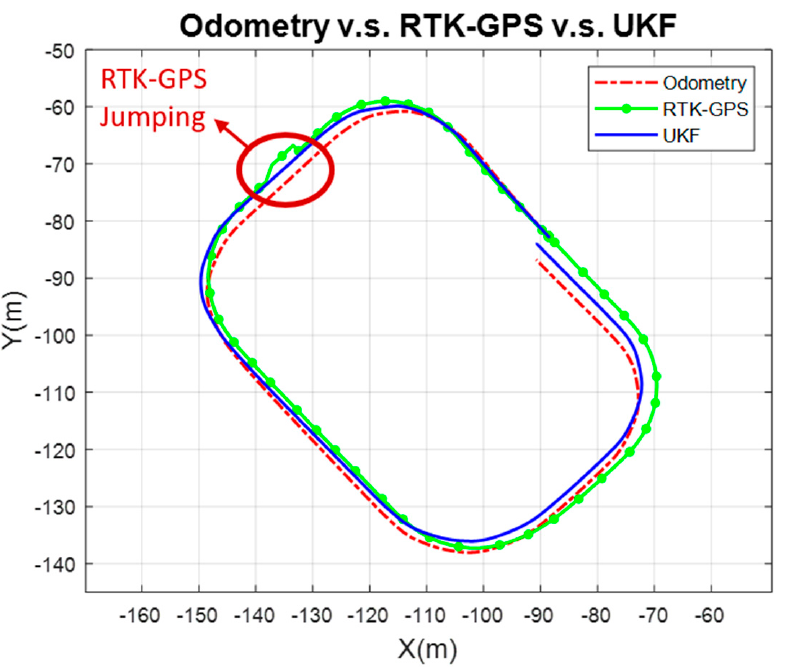
Figure 9. Trajectory comparison of odometry, RTK, and UKF.